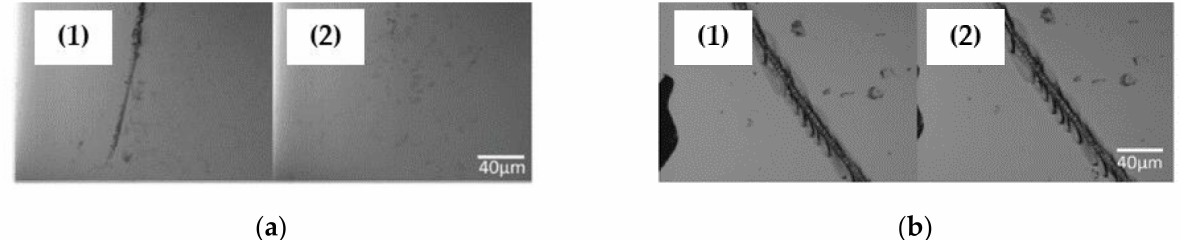
Figure 34. Optical images of damaged and repaired EA copolymers containing 3% of 7-methacryloyloxy coumarin as photoreactive pendant groups. ( a ) Healing an inserted crack (1) using light only (2) and ( b ) healing an inserted crack (1) by heating only (2). Republished with permission of the Royal Society of Chemistry, from [179]; permission conveyed through Copyright Clearance Center,